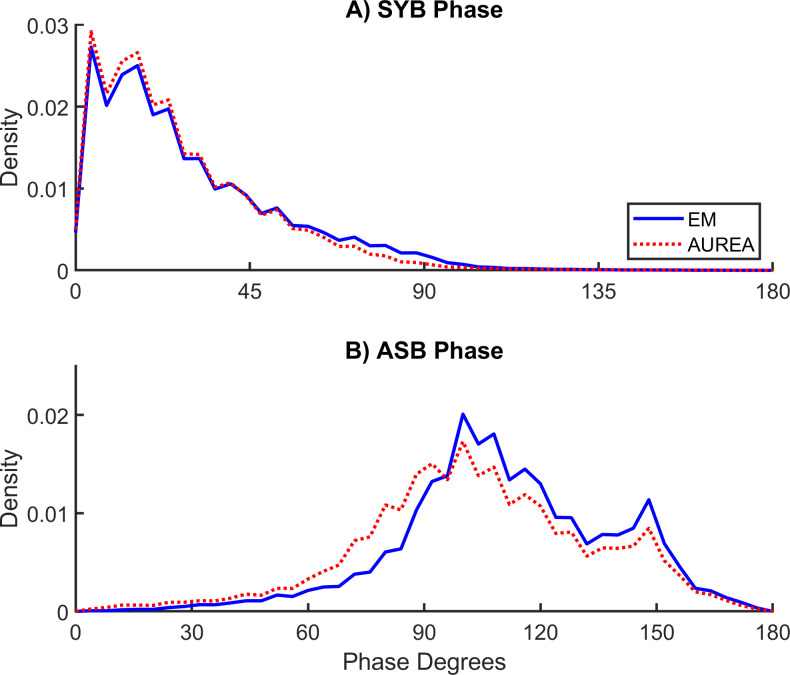
Instantaneous phase for synchronous (SYB) and asynchronous (ASB) samples.The threshold separating ASB from SYB samples was about 10o lower for the unsupervised respiratory event analysis (AUREA) compared with classification by expectation maximization (EM).